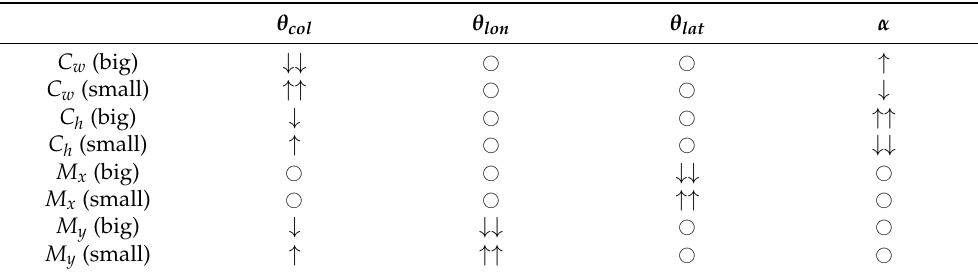
Table 1. Trim rules corresponding to loads change in helicopter wind tunnel test. (In the table, ↑↑ represents more increment, ↑ represents less increment, ↓↓ represents more decrease, ↓ represents less decrease,